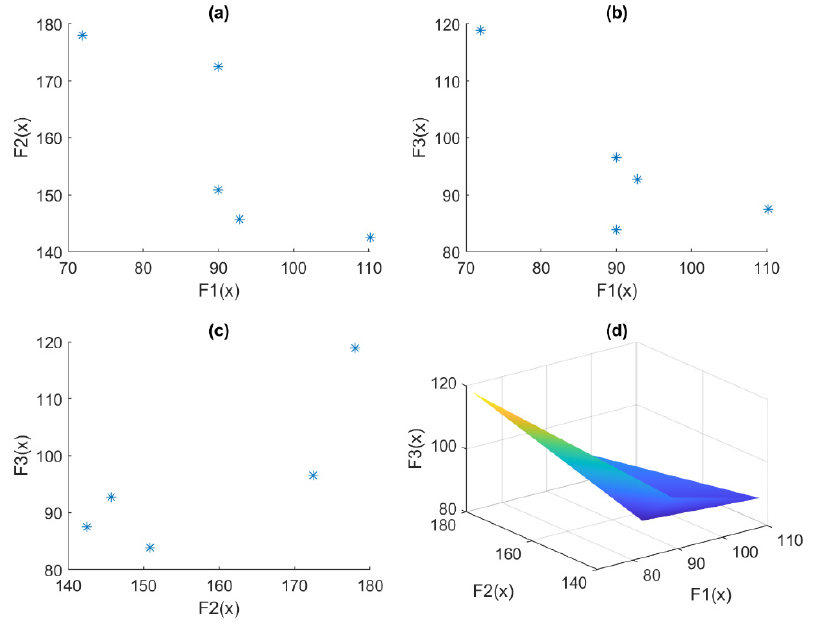
Figure 6. Results of NSGA-II method: ( a ) F1 vs. F2; ( b ) F1 vs. F3; ( c ) F2 vs. F3; ( d ) 3D plot.